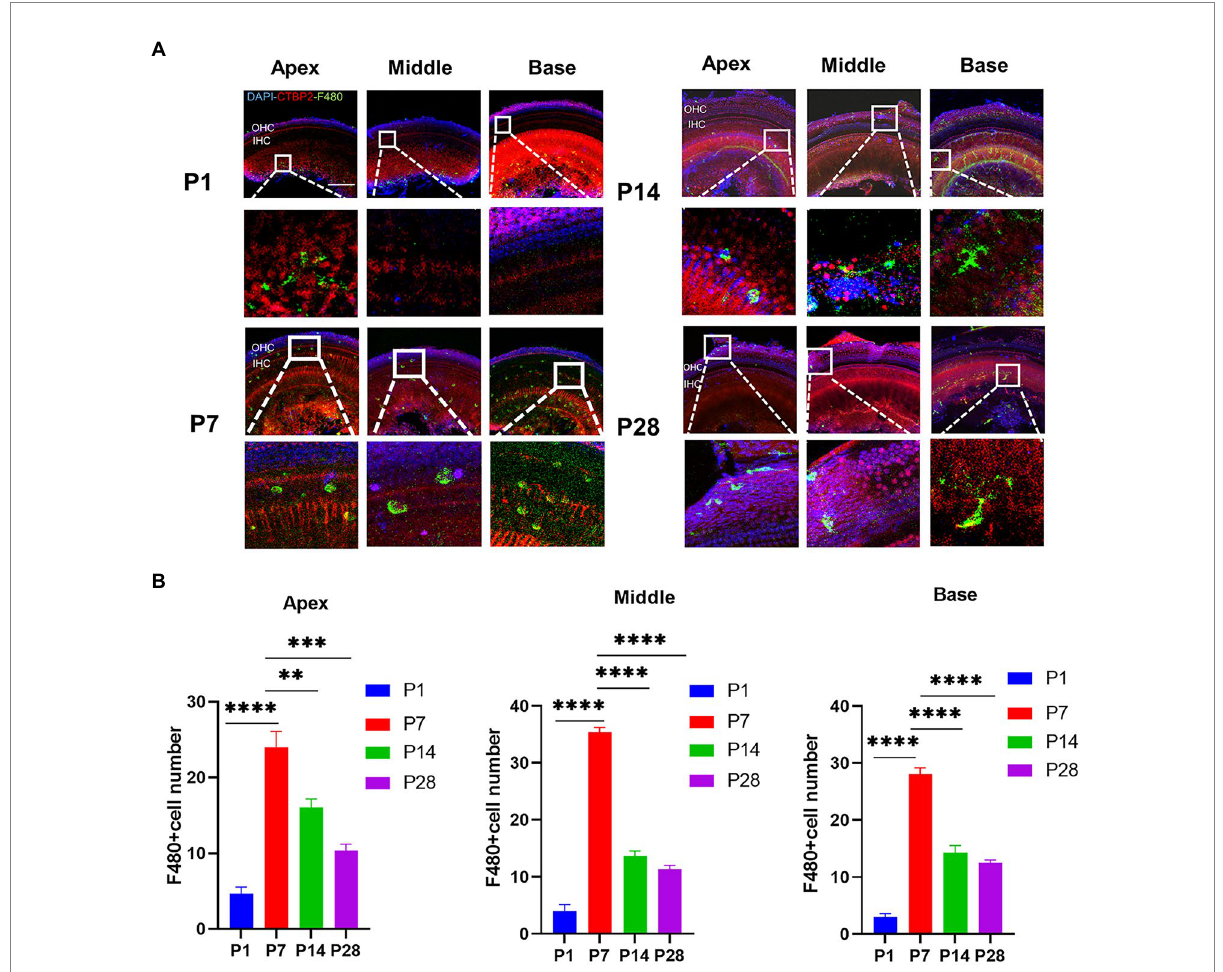
FIGURE 2 The number of macrophages during cochlear development in postnatal mice is detected from P1 to P28. (A) Immunofluorescence staining (green) is used to detect the dynamic changes in the number of macrophages on P1, P7, P14, and p28. Scale bar = 50 μ m, n = 3. At P7, macrophages have a round shape, while they have a dendritic shape after P14. (B) The number of macrophages is increased from birth to P7 and then decreased until